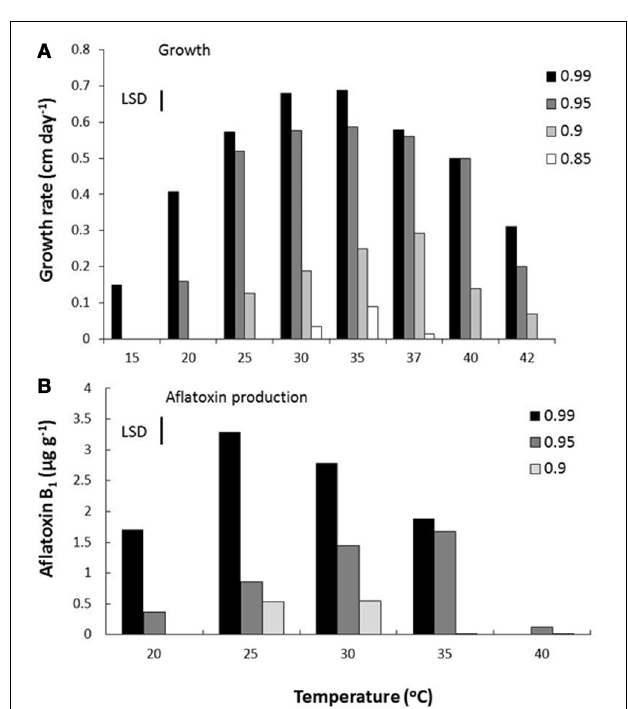
FIGURE 3 | Effect of water activity and temperature on (A) growth and (B) aflatoxin B 1 , production by a strain of A. flavus (Abdel-Hadi et al., 2012). Bars indicate least Significant